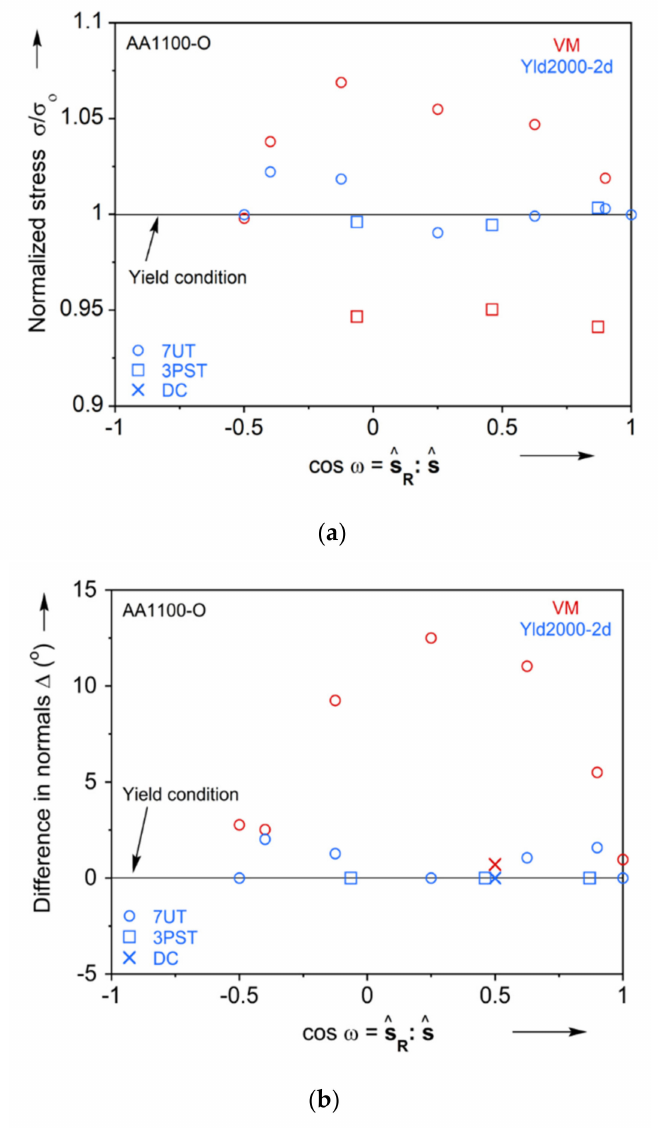
Figure A2. KBK anisotropy evaluation of ( a ) Yld2000-2d and ( b ) von Mises